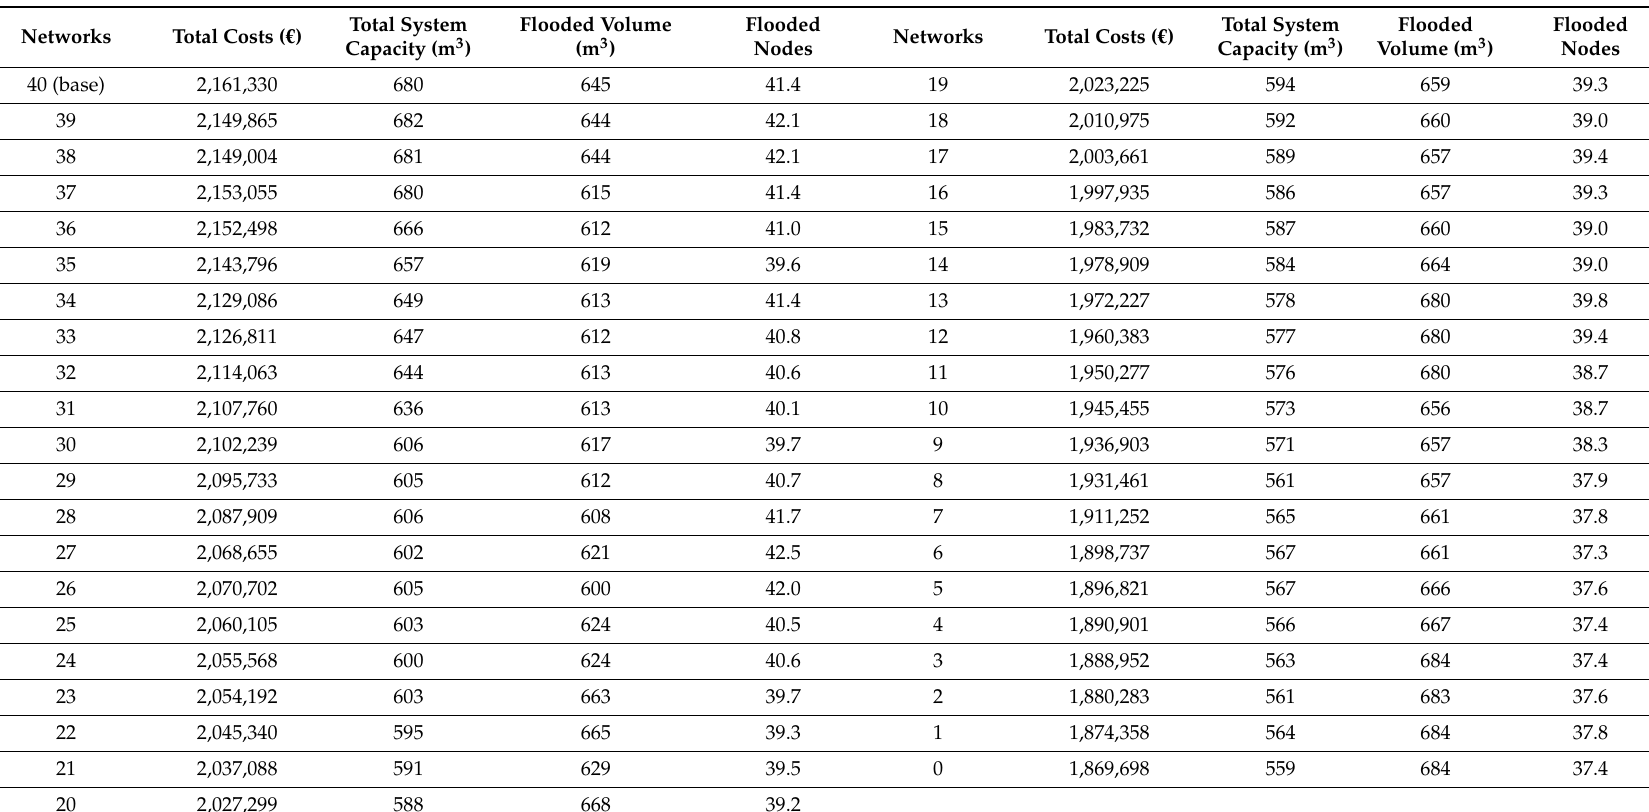
Table A3. Total construction costs ( € ), total system capacity (m 3 ), total weighted flooded volume (m 3 ) and total weighted number of flooded nodes for all 41 networks in which extra pipes are removed randomly (scenario